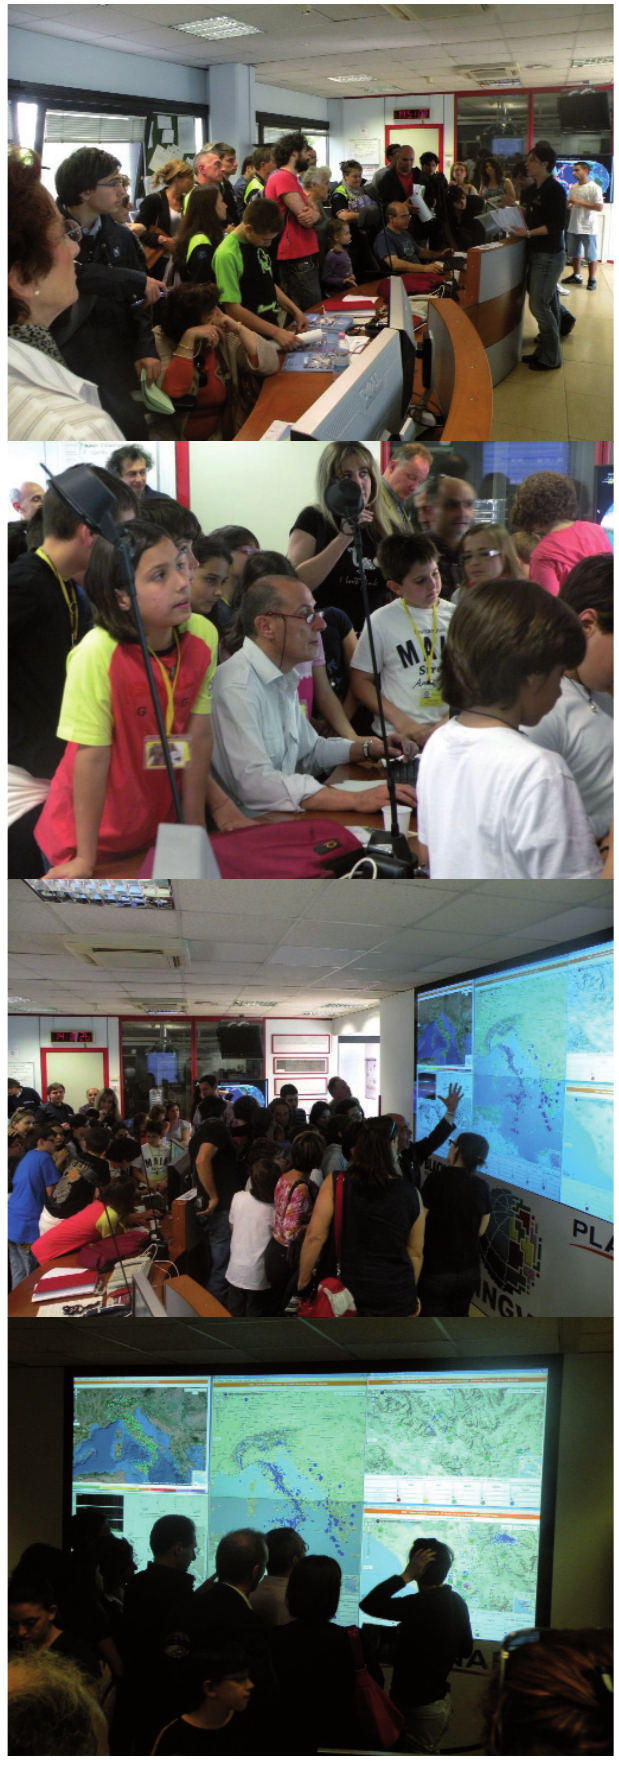
Figure 4. People inside the INGV seismicity monitoring